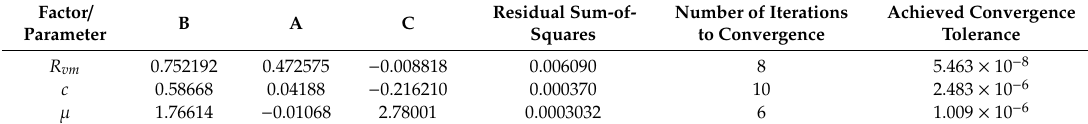
Table 6. Parameters of regression models R vm , c and µ .